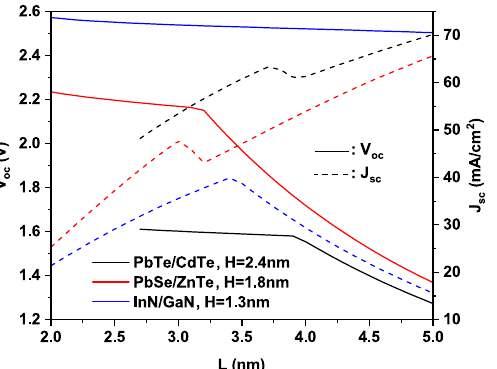
Figure 5. Variation of J sc (dashed lines) and V oc (solid lines) versus dot size L at the optimum inter-dot spacing H = 2.4 nm, 1.8 nm and 1.3 nm for PbTe/CdTe, PbSe/ZnTe and InN/GaN QD